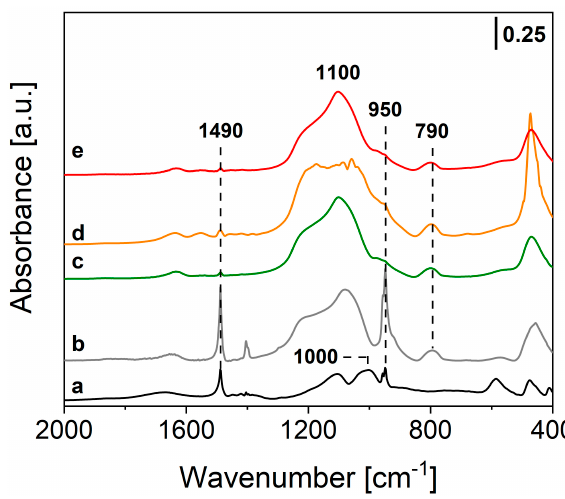
Figure 2. FTIR spectra of OctaTMA POSS (a), PSQ [24] (b), Tb-PSQ (c), TbEu-PSQA (d) and TbEu- PSQB (e), diluted in the KBr matrix (at 0.5 wt.%).